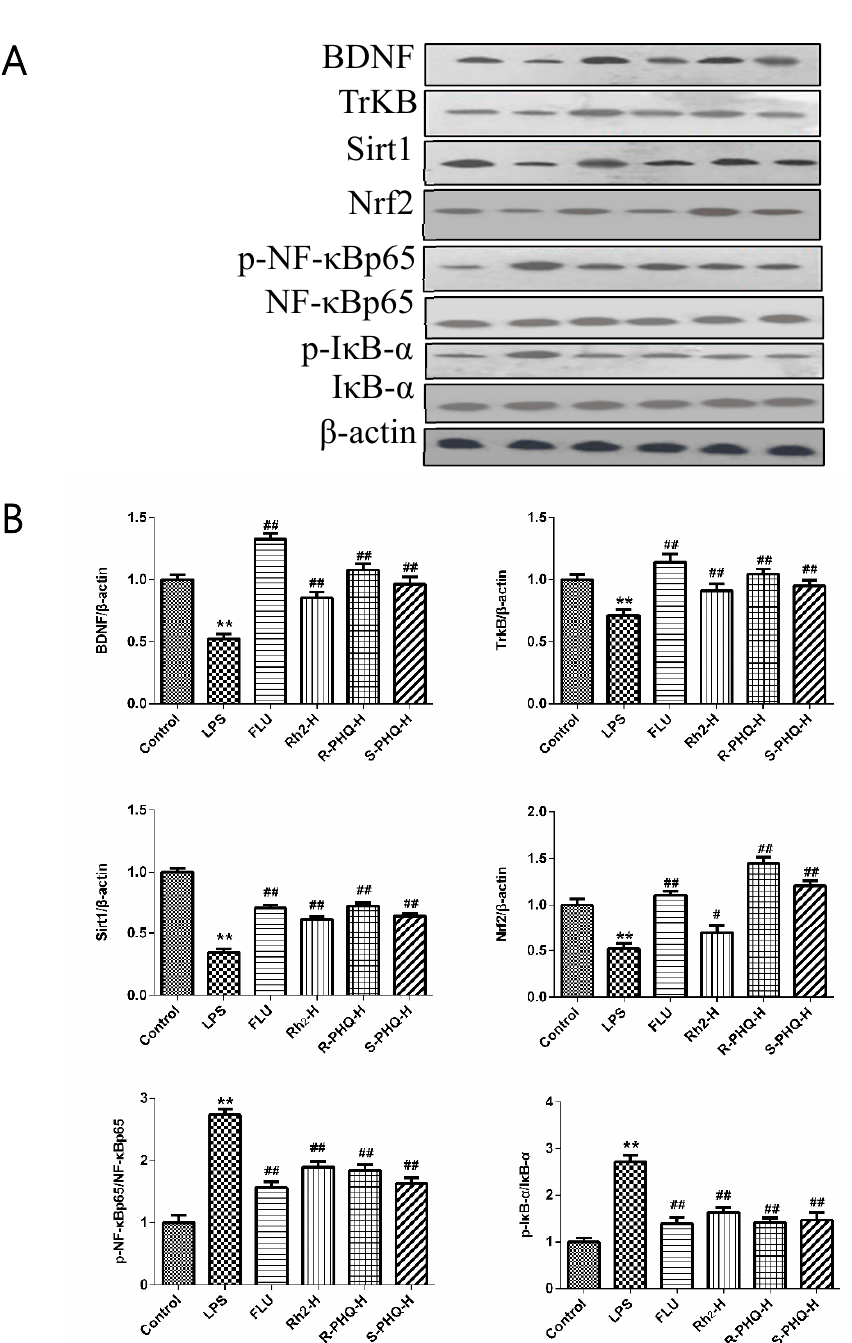
Figure 2. ( A ) Effects of Rh 2 , S -PHQ, and R -PHQ on the protein expressions of brain-derived neutrophic factor (BDNF), tropomyosin-related kinase B (TrkB), sirtuin type 1 (Sirt1), nuclear-related factor 2 (Nrf2), phosphorylated nuclear factor- κ B ( p -NF- κ B) p65, and phosphorylated inhibitor of κ B- α ( p -I κ B- α ) in mice hippocampus tissues; ( B ) quantitative analyses of BDNF, TrkB, Sirt 1, Nrf2, p -NF- κ Bp65, and p -I κ B- α in each group. Data are expressed as means ± SD ( n = 3); ** p < 0.01 as compared to the control group; # p < 0.05, ## p < 0.01 as compared to the LPS-treated